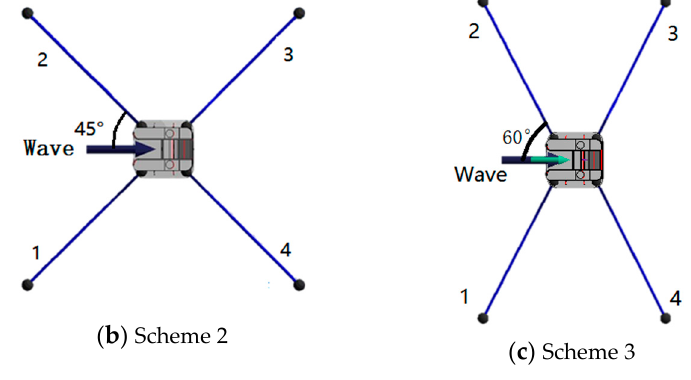
Figure 4. Mooring schemes.